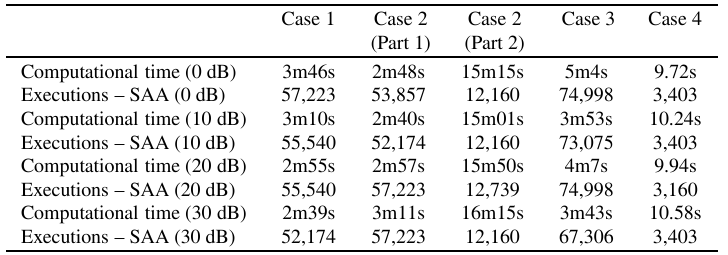
Table 3 Computational effort for the PSO-LM method